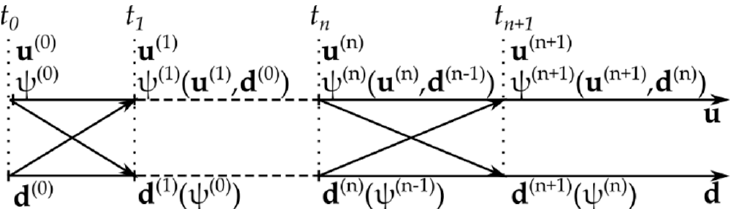
Figure 4. Staggered iterative scheme for phase-field modeling in FEM software ( u —displacement vector, d —damage vector, ψ —internal potential energy density, t —time) [20].